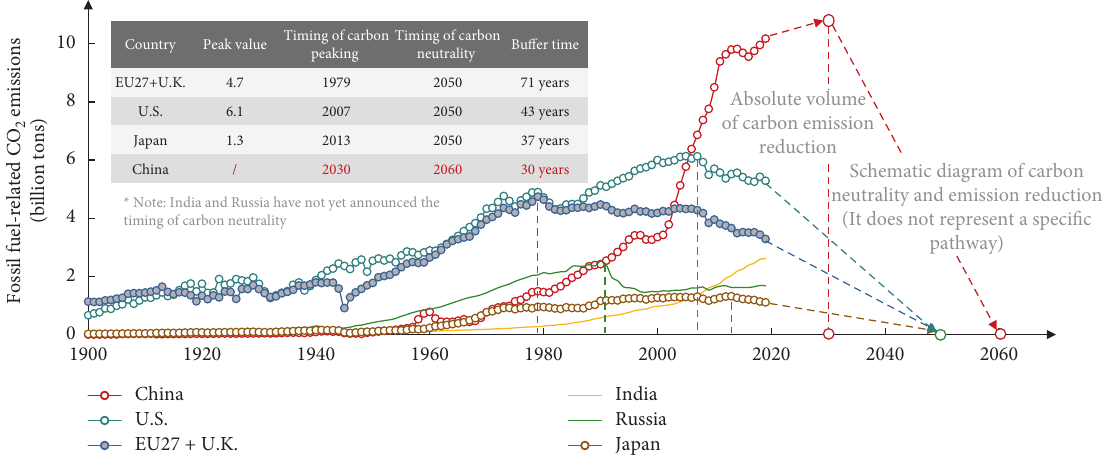
Figure 3: Fossil fuel-related carbon emissions and carbon neutrality plans of major countries in the world [27,